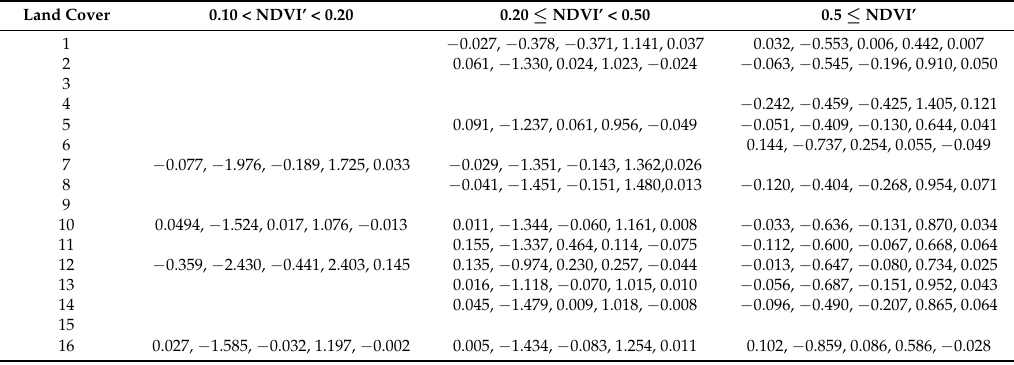
Table 7. Surface Reflectance Coefficients for 0.67 µ m for